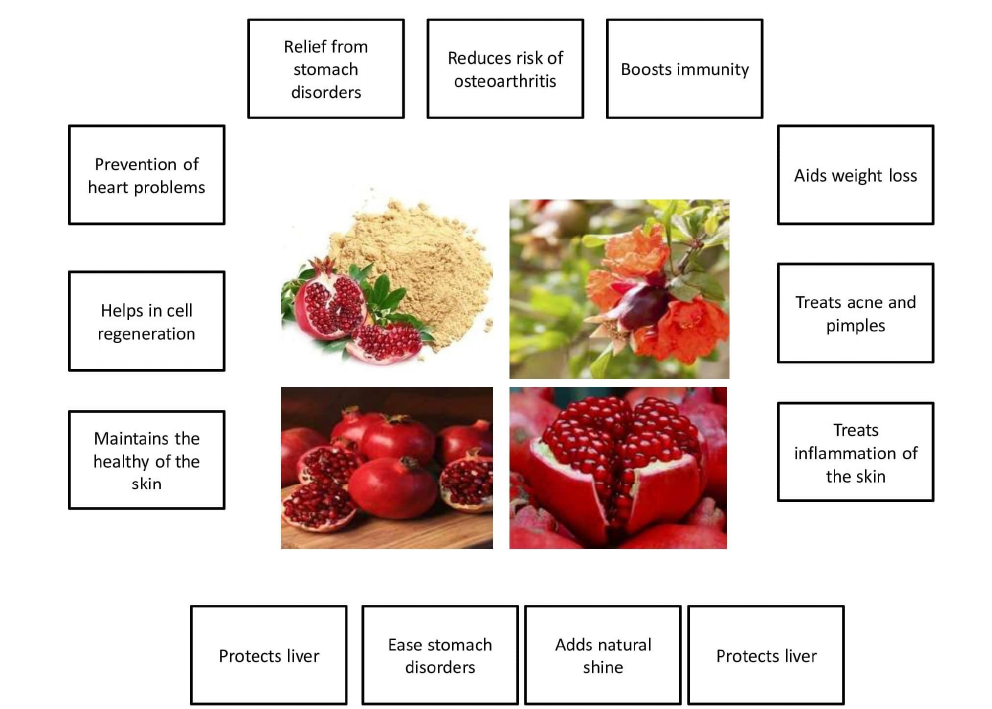
Figure 1. The most important health benefits of